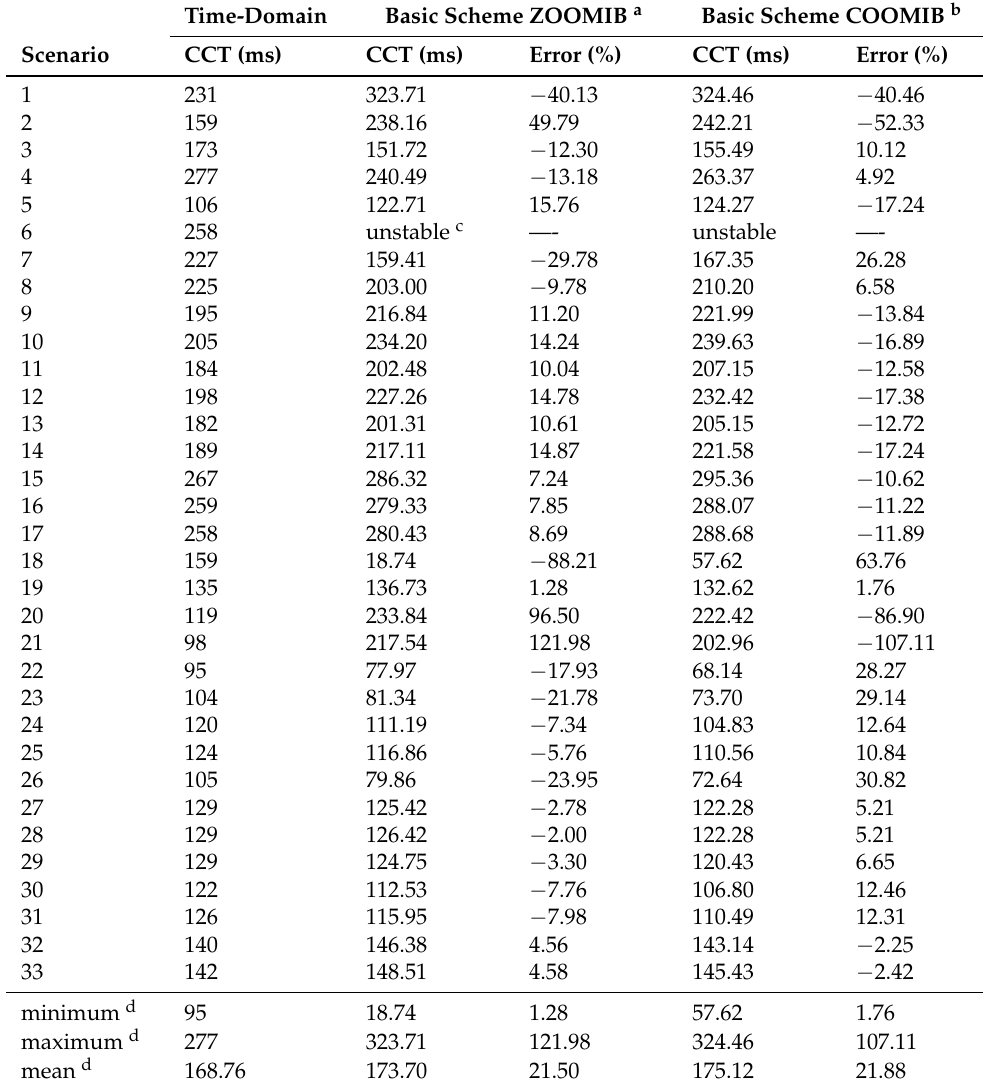
Table 3. A comparison between time-domain simulation results with the results obtained with different basic schemes for the French